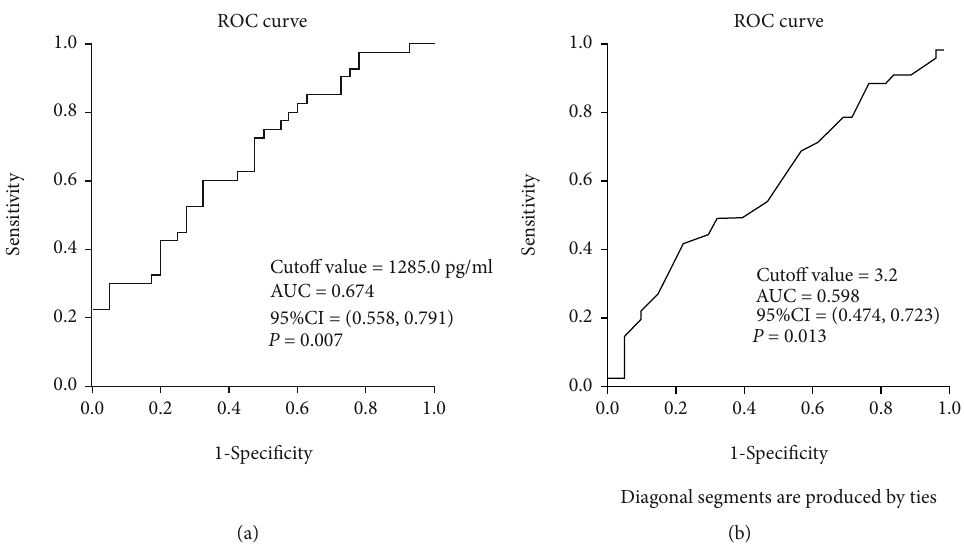
Figure 6: ROC curve and parameters for predicting CRSwNP recurrence: (a) serum BAFF; (b) peripheral eosinophil count. ROC: receiver operating characteristic; CRSwNP: chronic rhinosinusitis with nasal polyps; BAFF: B cell-activating